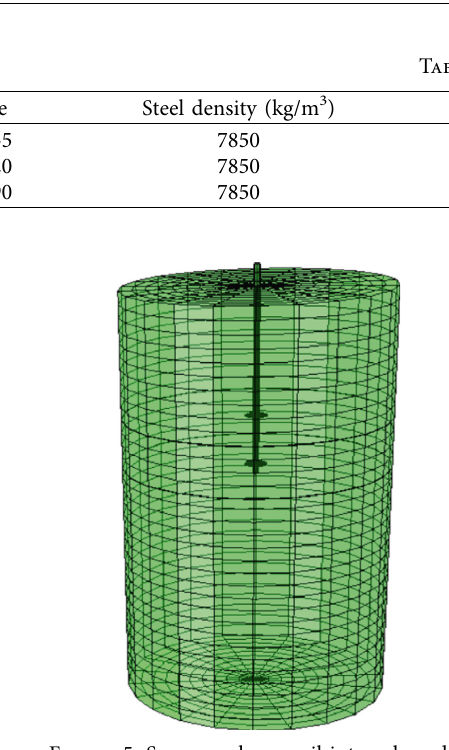
Figure 5: Screw anchor—soil integral model.